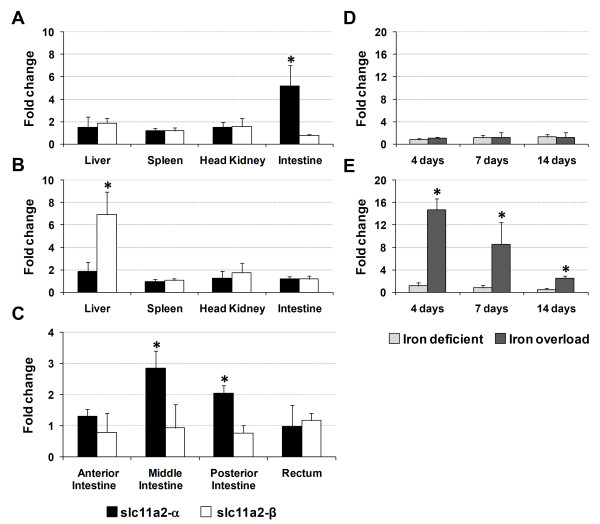
Sea bass slc11a2-α and slc11a2-β expression in several tissues, after iron modulation. Slc11a2-α and slc11a2-β expression 4 days after (A) iron deficiency or (B) iron overload induction; (C) slc11a2-α and slc11a2-β expression in several sections of the intestine, 4 days after iron deficiency induction; slc11a2-α and slc11a2-β expression in the liver during 14 days of (D) iron deficiency or (E) iron overload. Values are expressed as means ± S.D. (n = 5). Differences from the controls were considered significant for *p < 0.05.